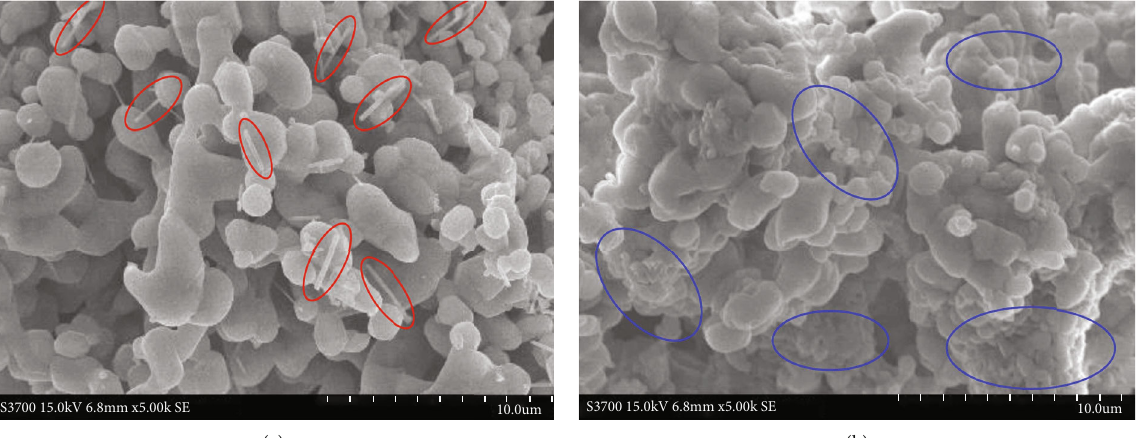
Figure 3: Morphology of (a) CS-800 and (b) 15wt.% Na